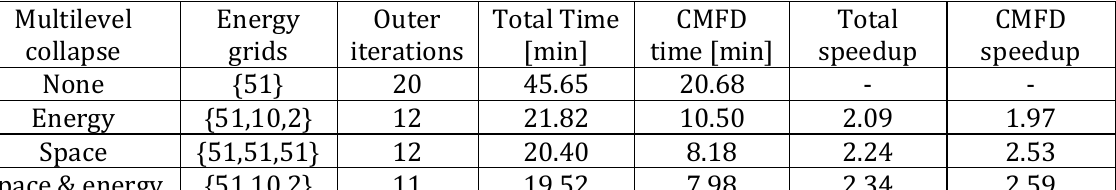
Table I. Problem 5 runtime.